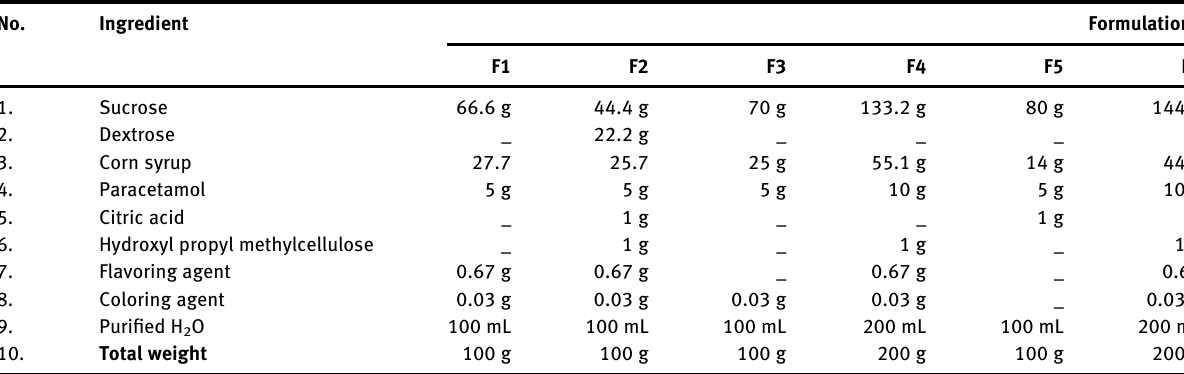
Table  : Formulas of preparation of paracetamol